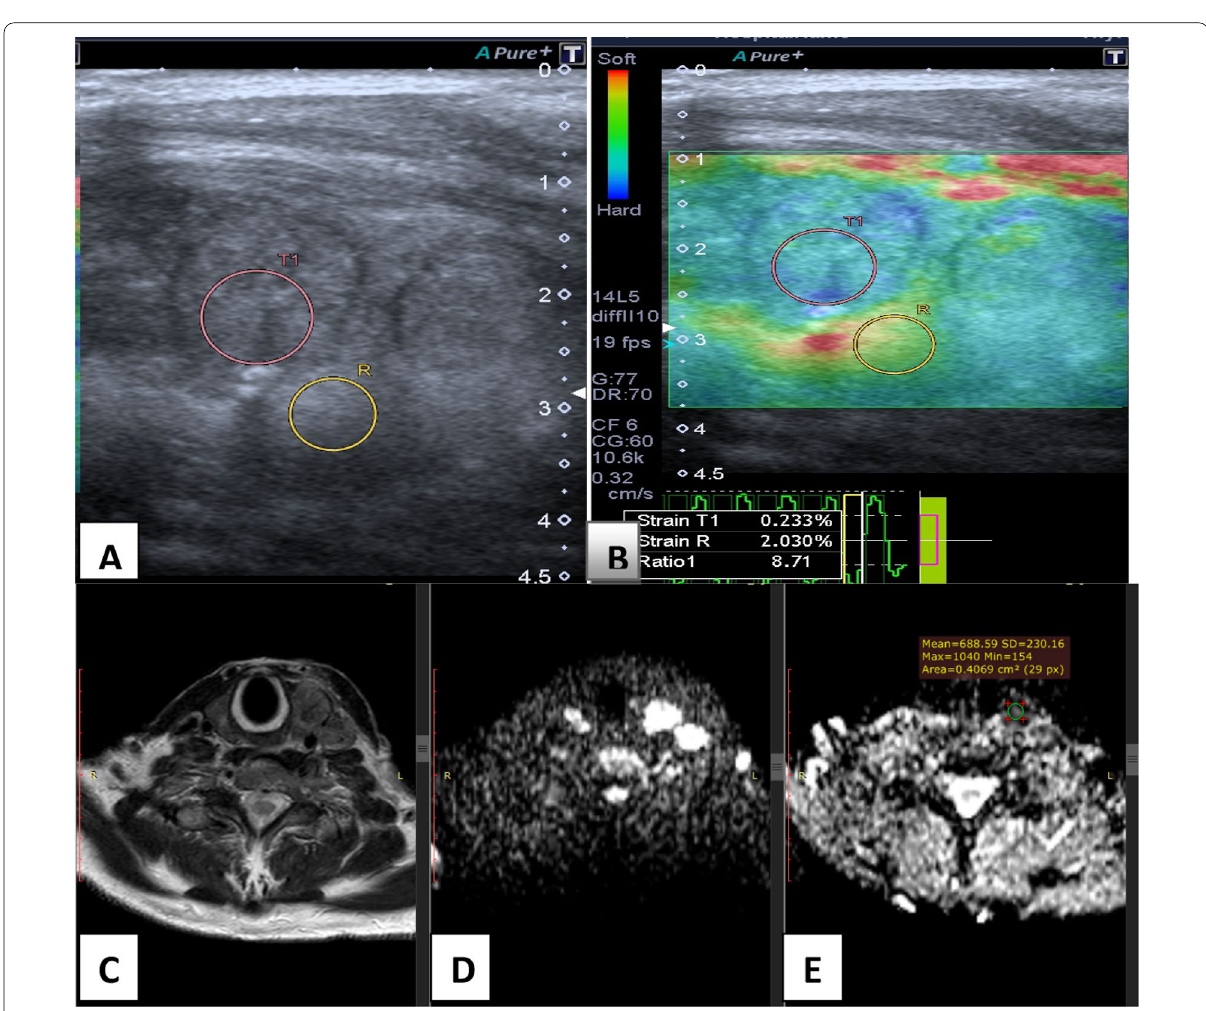
Fig. 3 Male patient aged 65 years presented with left lobe nodule. Ultrasound features of the nodule A : The left lobe shows solid nodule isoechoic to the surrounding thyroid tissue, wider more than taller with well-defined outline. Marginal macro-calcifications are noted. TIRADS categorization: TIRADS (5). On elastography color map B : most of the nodule is shaded with blue with small green areas are seen. Elastography score: (3) Strain ratio 8.7. MRI study: T2 weighted image C : left lobe nodule isointense to the surrounding normal thyroid parenchyma. Diffusion weighted images = D : the nodule shows high signal intensity. ADC mapping E : it shows low signal with ADC value